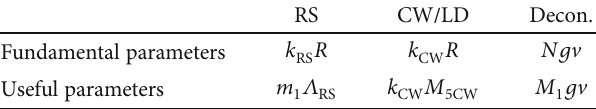
Table 1: Free parameters of warped extradimensions (RS), Clockwork/Linear Dilaton, and deconstruction. The fi rst parameter set represents the fundamental parameters of each model. The second parameter set shows the parameters that are useful for phenomenology (mass gap and coupling). RS CW/LD Decon. Fundamental parameters k RS R k CW R Ngv Useful parameters m 1 Λ RS k CW M 5CW M 1